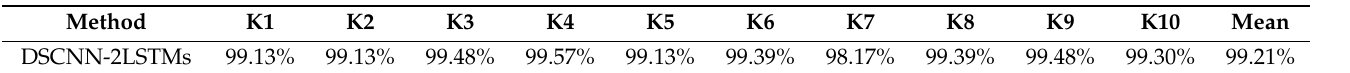
Table 4. The Performance of DSCNN-2LSTM model after adjusting classification weight on the binary classification task.